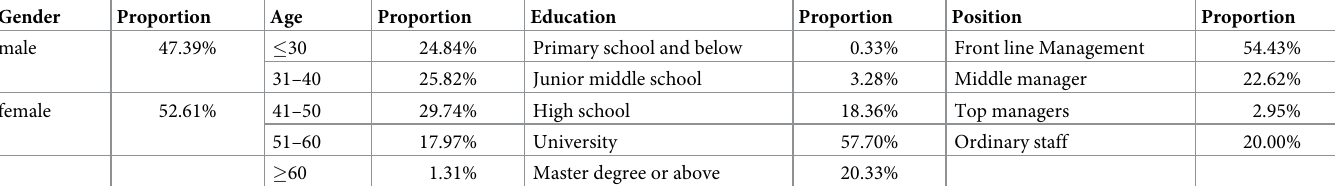
Table 1. Interviewers in the survey sample.